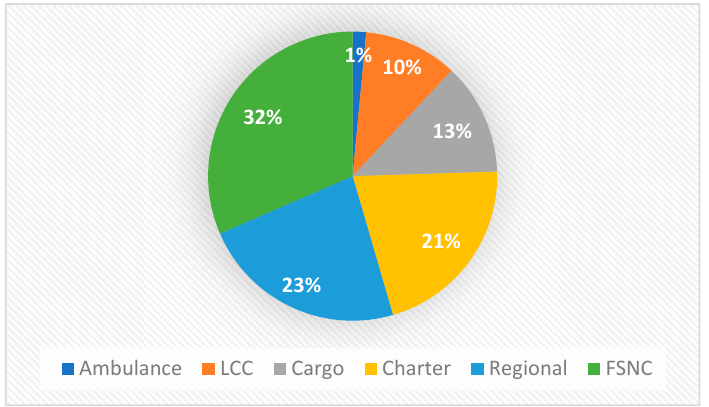
Figure 1. Percentage of safety accidents related to human error, for different air carrier operations. The majority of the accidents are related to air cargo operations.